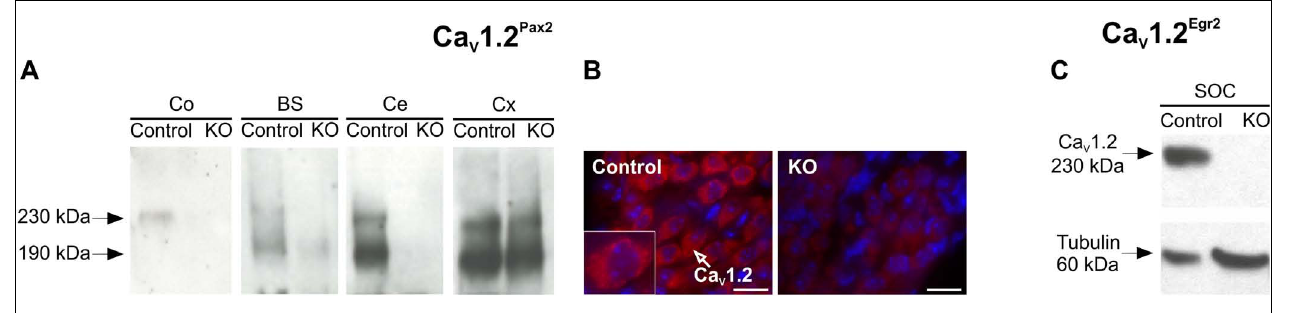
FIGURE 1 | Tissue-specific deletion of Ca V 1. 2 in Ca V 1.2 Pax2 KO and Ca V 1.2 Egr2 KO mice. (A) Western blot for Ca V 1.2 protein (230 and 190 kDa proteolytic product) in mouse cochlea (Co), brainstem (BS), cerebellum (Ce),